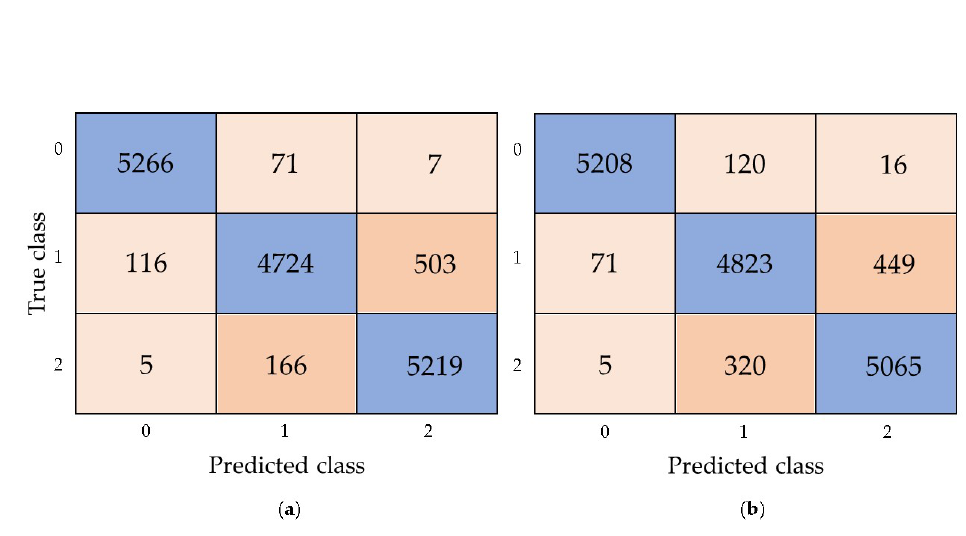
Figure 5. Confusion matrix for ( a ) SVM classifier, ( b ) BT classifier, applied on cross-domain physio- logical and acceleration data.